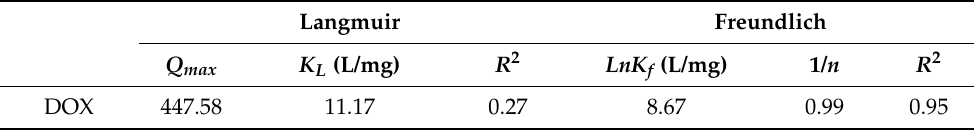
Table 1. Isotherm parameters according to the Langmuir and Freundlich models.